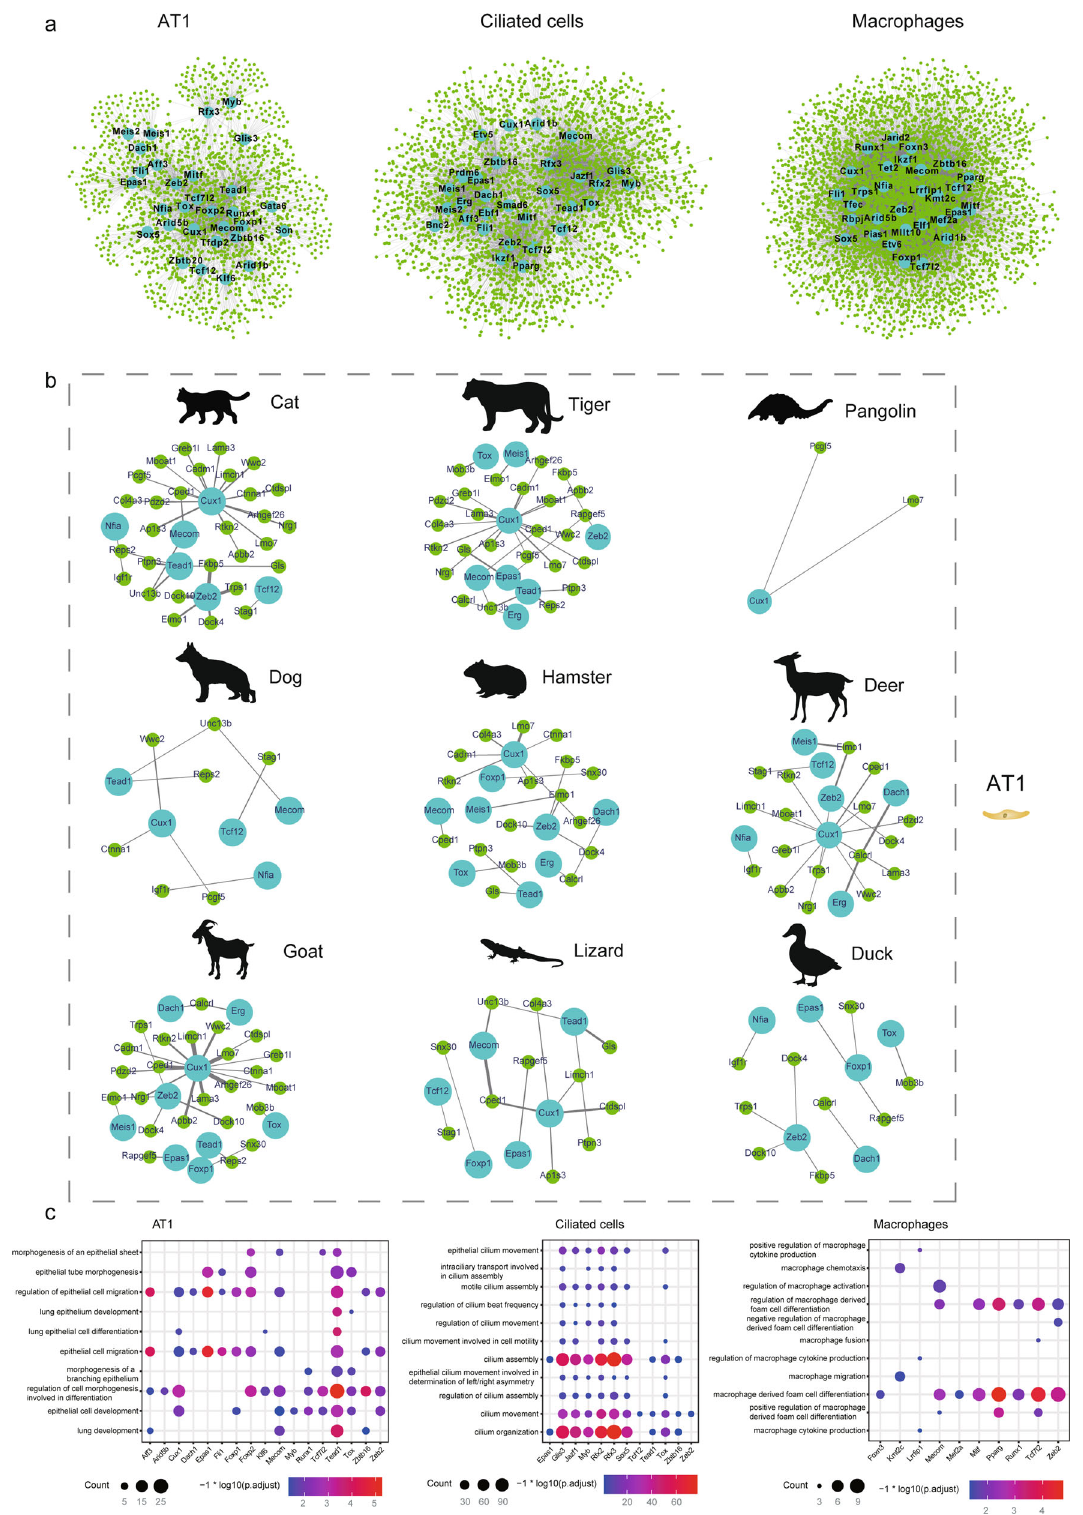
Fig. 6 Conservation of regulomes in pulmonary cells. a Genetic regulatory network constructed with top 30 TFs with largest number of interactions and predicted target genes in AT1 cells, ciliated cells, and macrophages. b Highly conserved genetic regulatory networks in AT1 cells within each indicated species. Light blue nodes represent regulators, green nodes represent corresponding target genes. Edge width is proportional to weight of regulation and node size is proportional to number of target genes of regulator. c GO enrichment related to cellular functions of predicted target genes of top 30 TFs in AT1 cells, ciliated cells, and macrophages, respectively. Dot color represents signi fi cance level of enrichment analysis and dot size is count of target genes classi fi ed in GO terms. P -values were calculated using hypergeometric test. Multiple comparisons adjustment was performed using Benjamini and Hochberg method. Exact P -value and source data were included in the Source Data fi